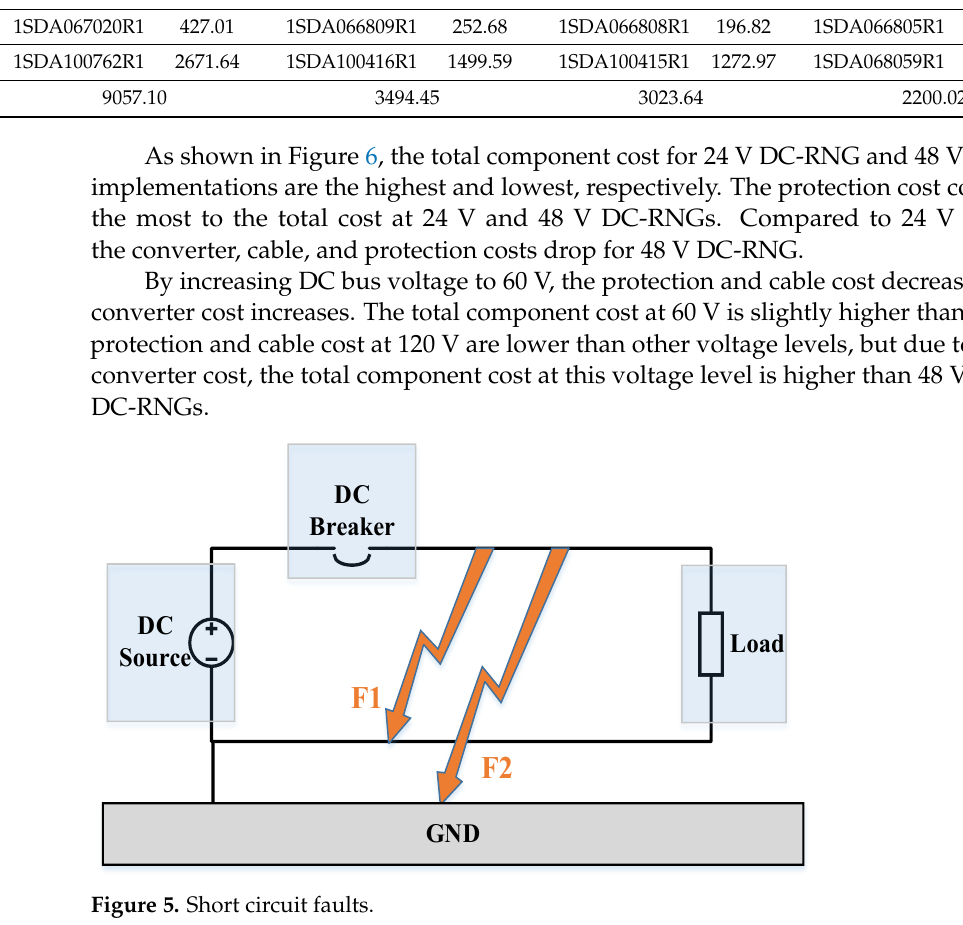
Figure 6. Total component cost at each voltage level.